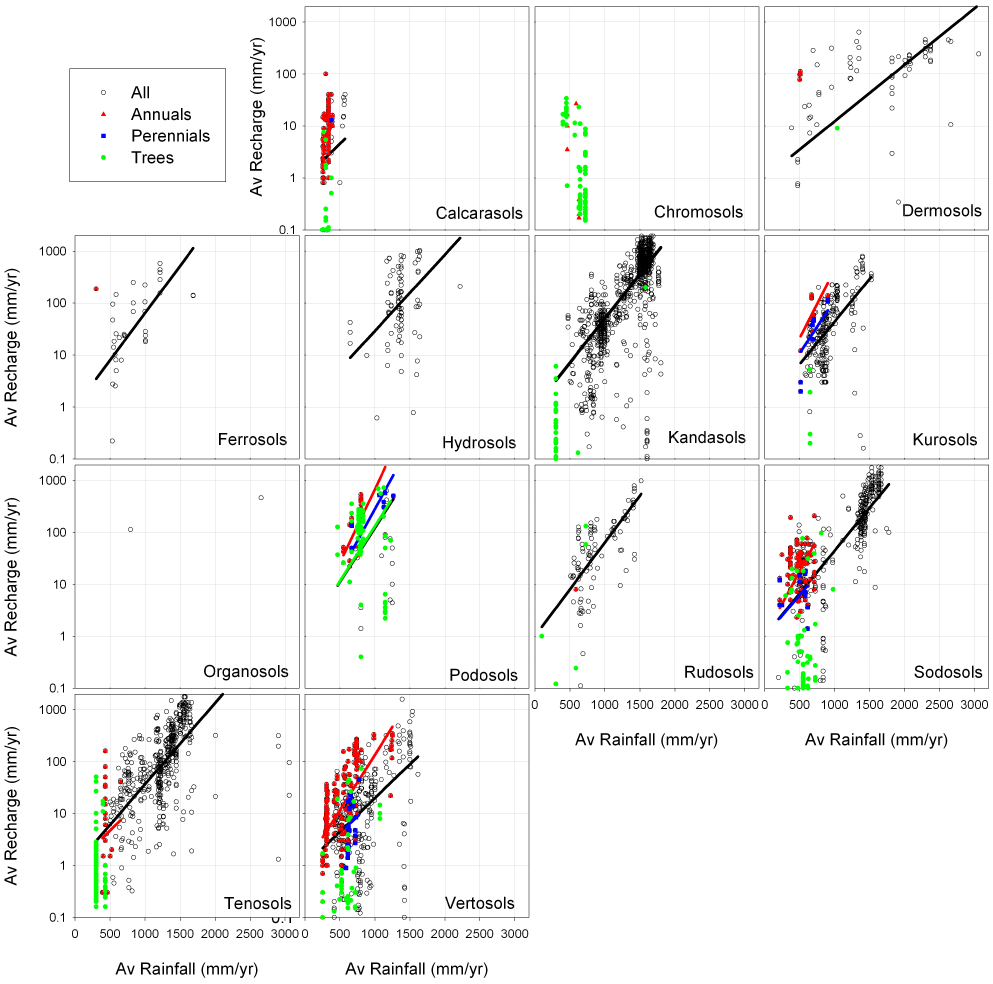
Fig. 10. The relationship between rainfall and recharge when categorised by soil order. The class “all” is all the recharge estimates irrespective of vegetation